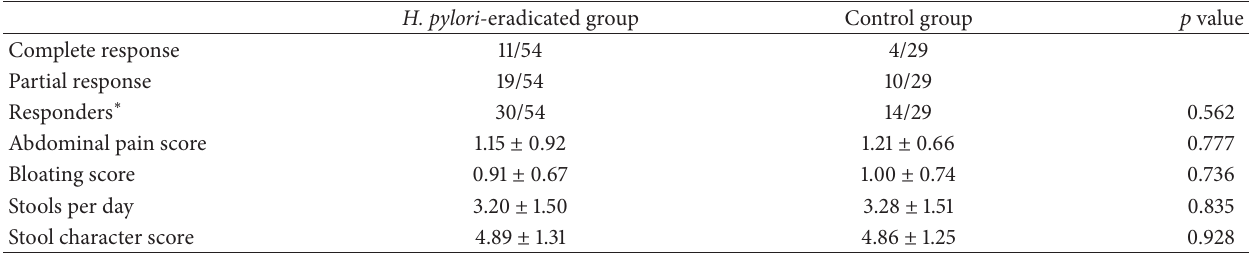
Table 2: Main study outcomes in the H. pylori -eradicated group and the control group in patients of follow-up.